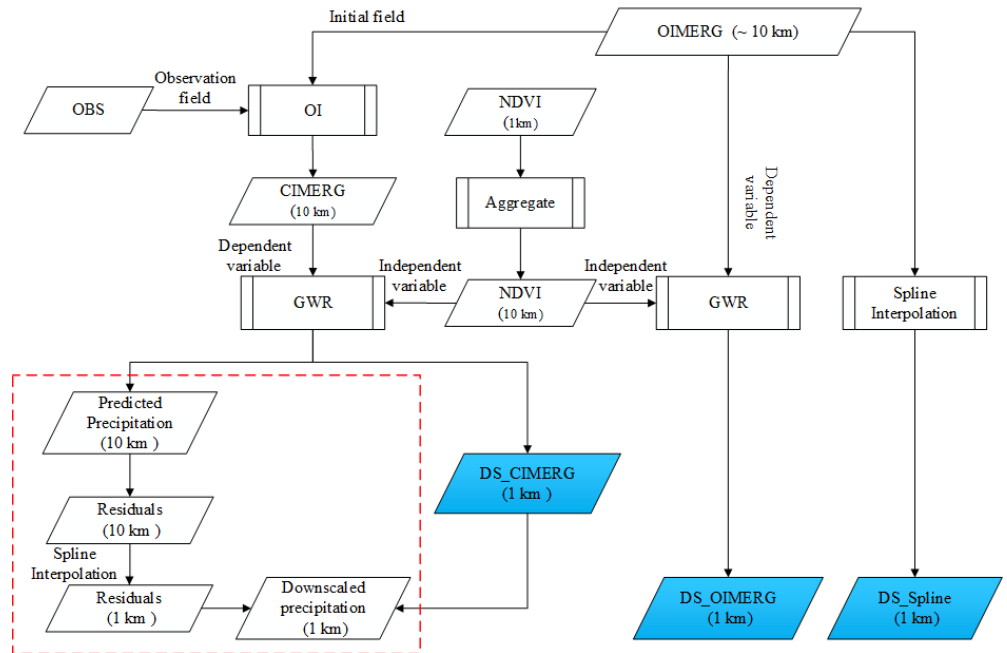
Figure 2. The flow chart of this study. The red dashed box indicates the residual correction process, and the blue boxes represent the three categories of downscaling estimation data. OIMERG, original Integrated Multi-satellitE Retrievals for GPM; OBS, observed precipitation data; OI, optimum interpolation; NDVI, normalized difference vegetation index; CIMERG, OI-corrected IMERG precipitation data; GWR, geographically weighted regression; DS_CIMERG, obtained via GWR downscaling with CIMERG; DS_OIMERG, obtained via GWR downscaling with OIMERG; DS_Spline, obtained by using the spline interpolation method for OIMERG precipitation downscaling.